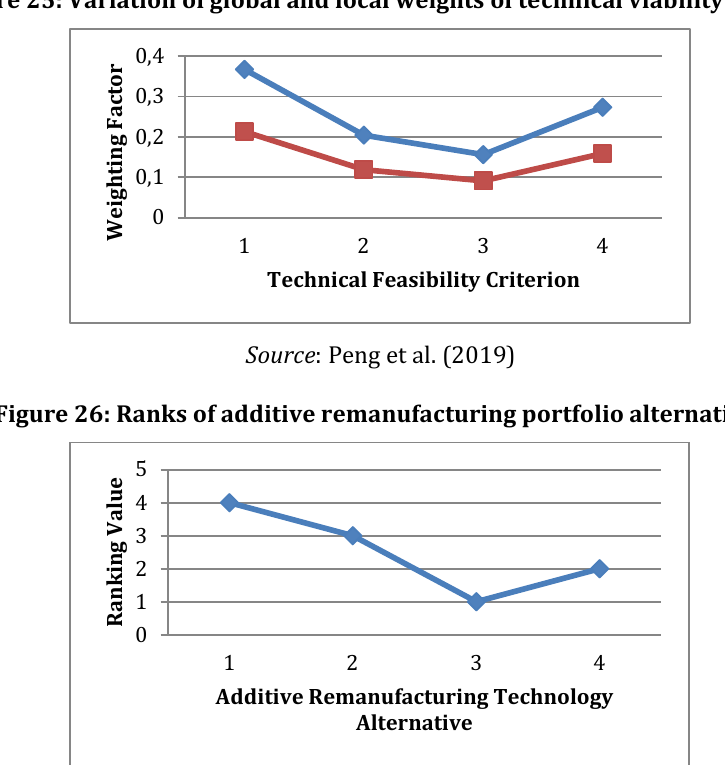
(1): Laser Cladding, (2): Plasma Arc Surfacing, (3): Brushing electroplating, (4): Plasma